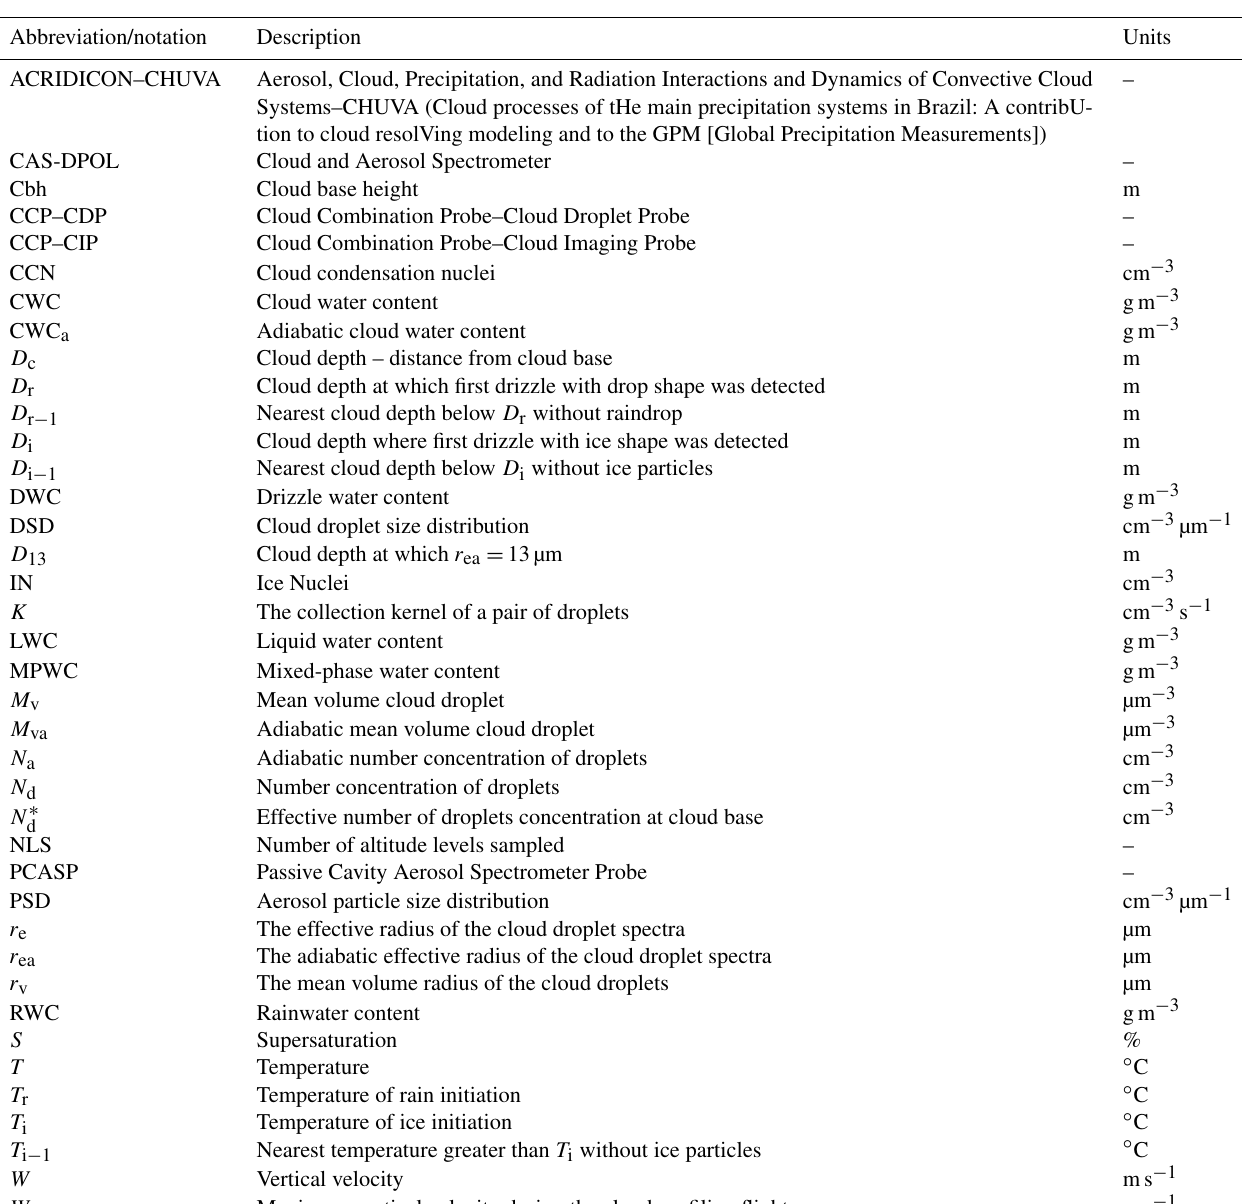
Table 1. List of abbreviations and